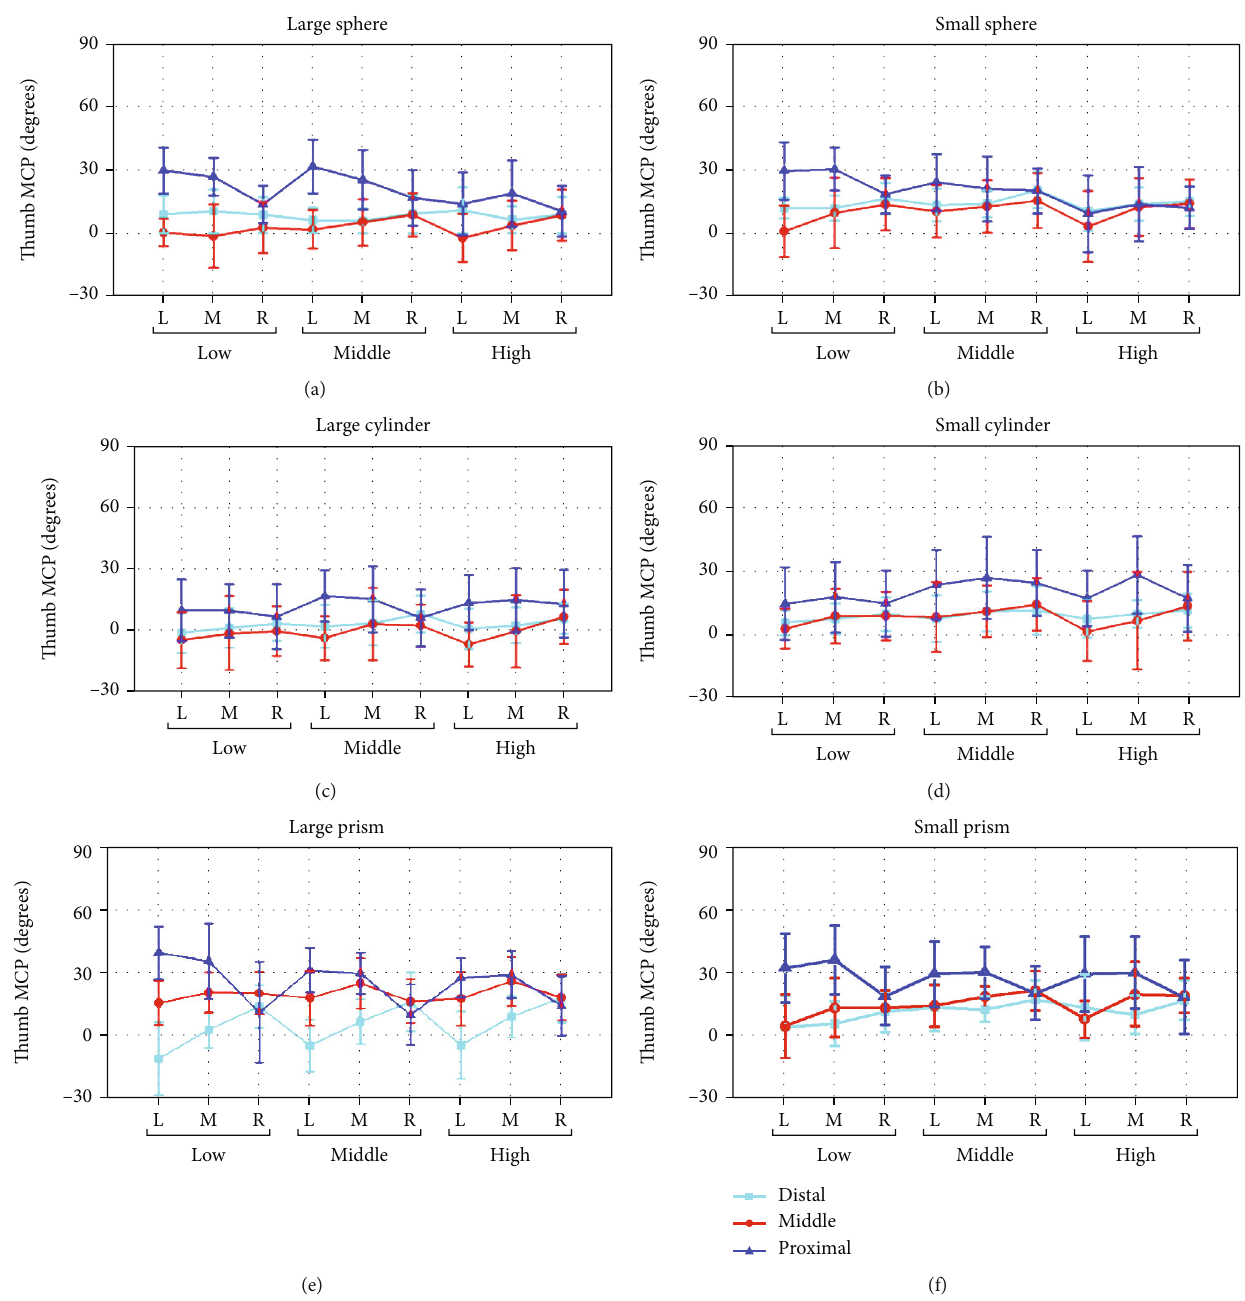
Figure 6: Thumb MCP joint rotation angle in fl uenced by the object shape, object size, X deviation, Y deviation, and Z deviation. L, M, and R represent the X deviation from left to right. Low, middle, and high represent the Z deviation from low to high. Distal, middle, and proximal represent the Y deviation from distal to